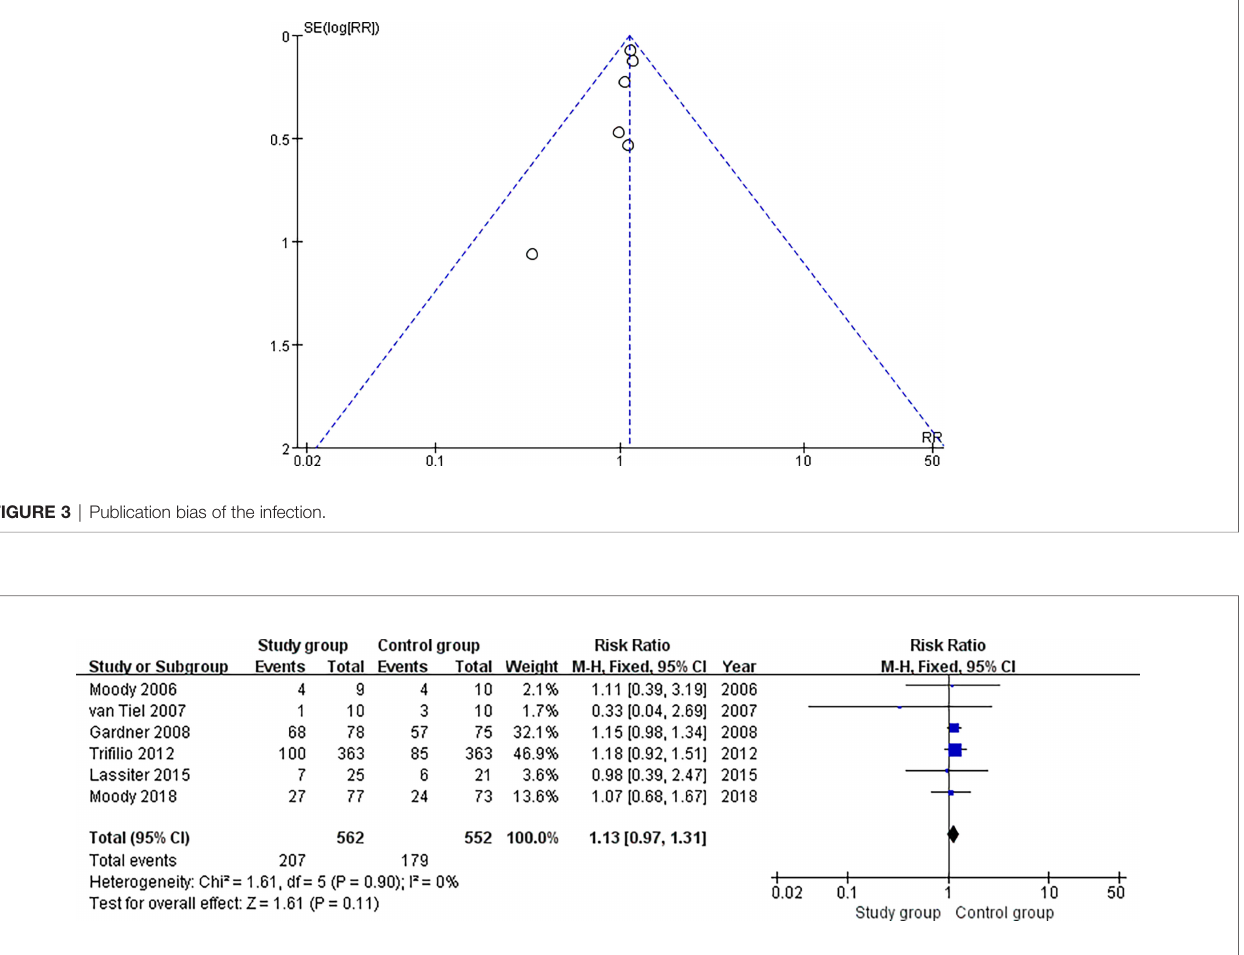
FIGURE 4 | Meta-analysis of the incidence of infection.